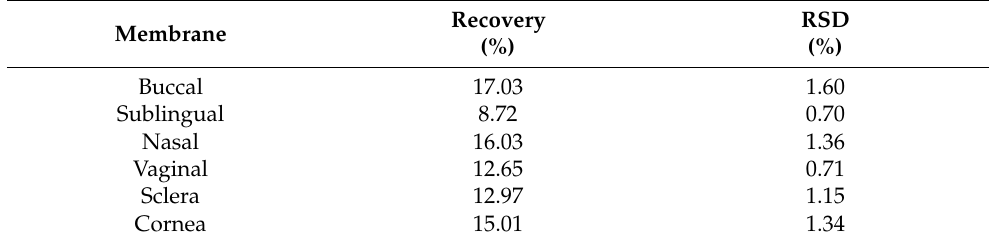
Table 11. The results of the pranoprofen recovery with phosphate-buffered saline (PBS), expressed as a percentage of the recovery, and its relative standard derivation (%RSD); n = 3 each.